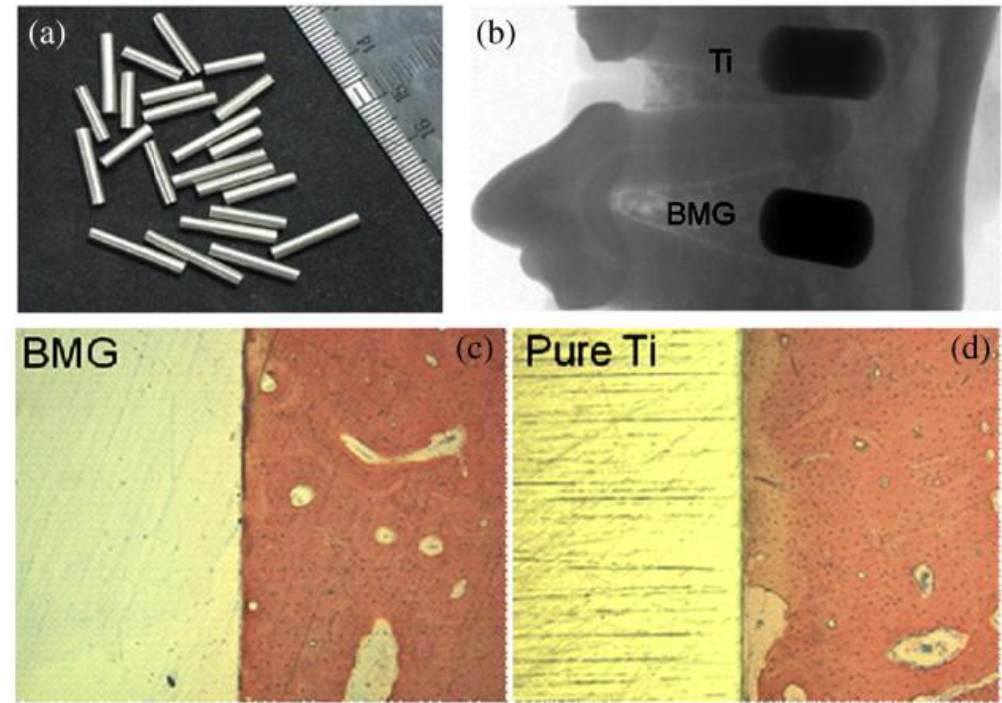
Figure 15. Implantation of Ti 41.5 Zr 2.5 Hf 5 Cu 37.5 Ni 7.5 Si 1 Sn 5 BMG and pure Ti samples. ( a ) BMG sample; ( b ) representative X-ray images for the implants; ( c , d ) representative histological images stained by methylene blue after 1 month of implantation [229]. Reproduced with permission from [229]. Copyright 2013, Elsevier.